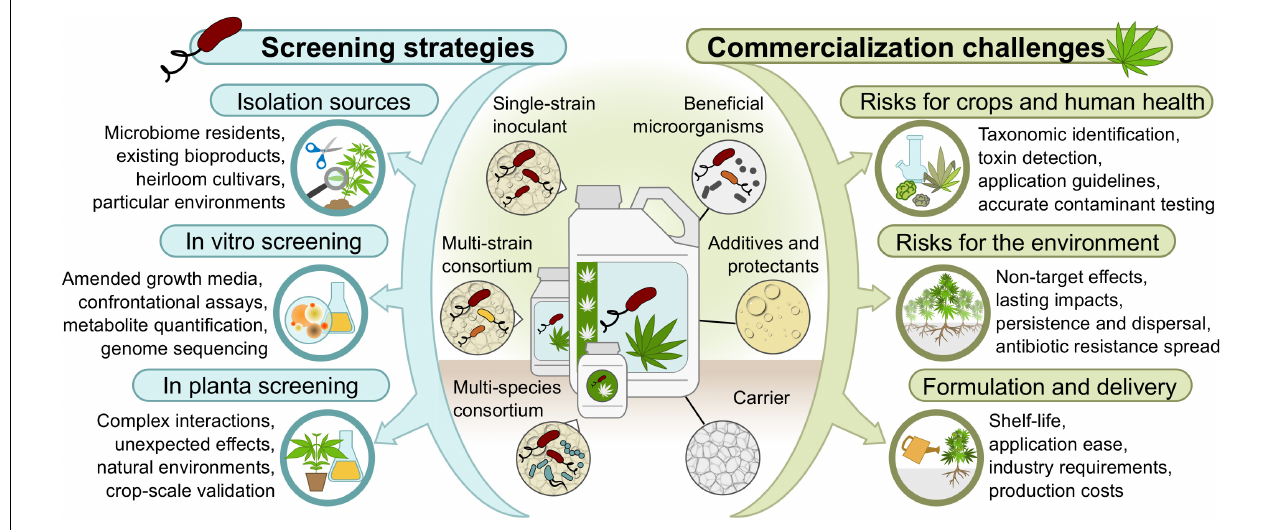
FIGURE 2 | Strategies and bottlenecks to identify beneficial Pseudomonas strains and develop bioproducts for cannabis